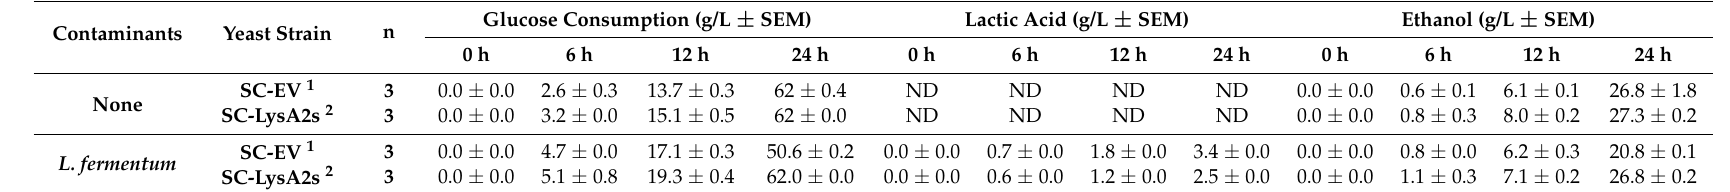
Table 3. Fermentation profile of SC-EV 1 and SC-LysA2s 2 in simulated